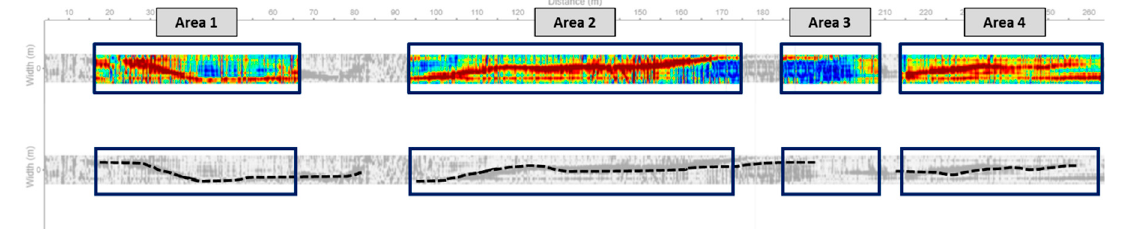
Figure 6. Highlight on the profile structure and related morphology.